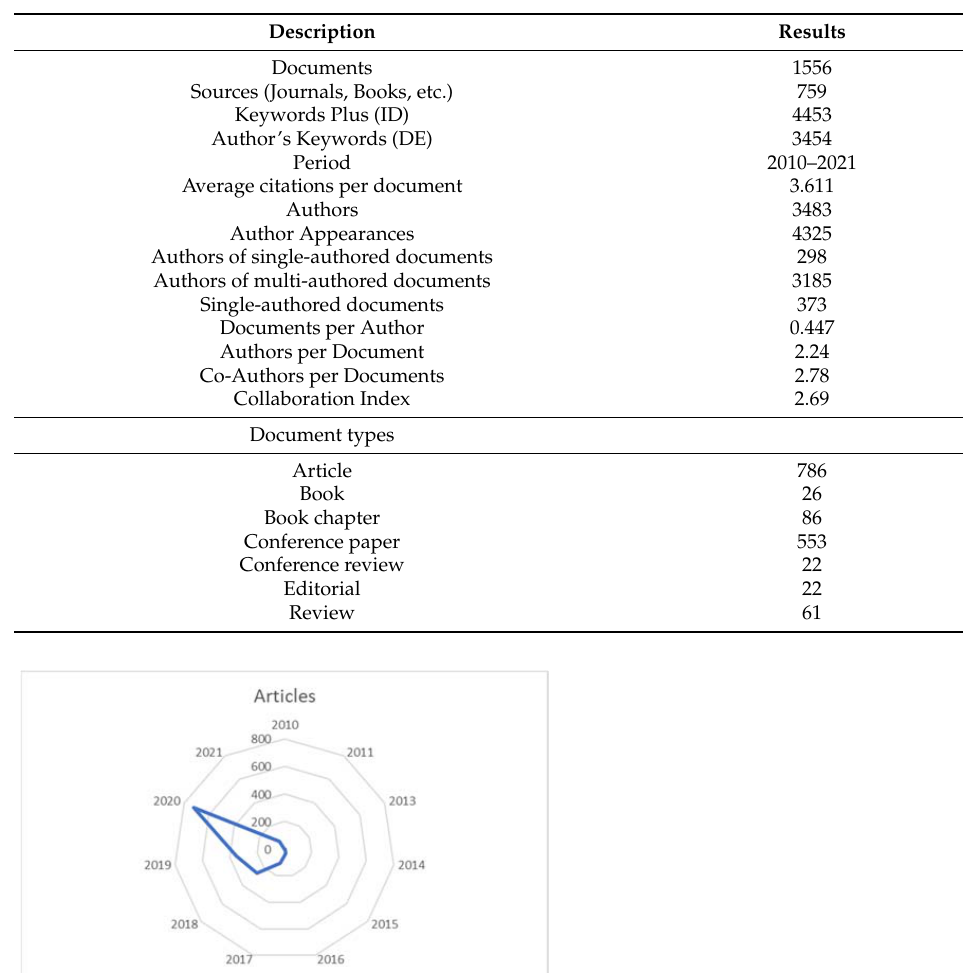
Table 1. Main information about fintech literature.